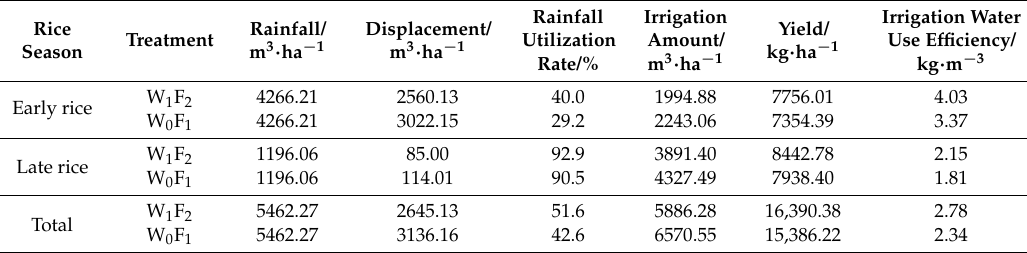
Table 2. Effect of water-fertilizer comprehensive regulation technique on water conservation in rice paddies.